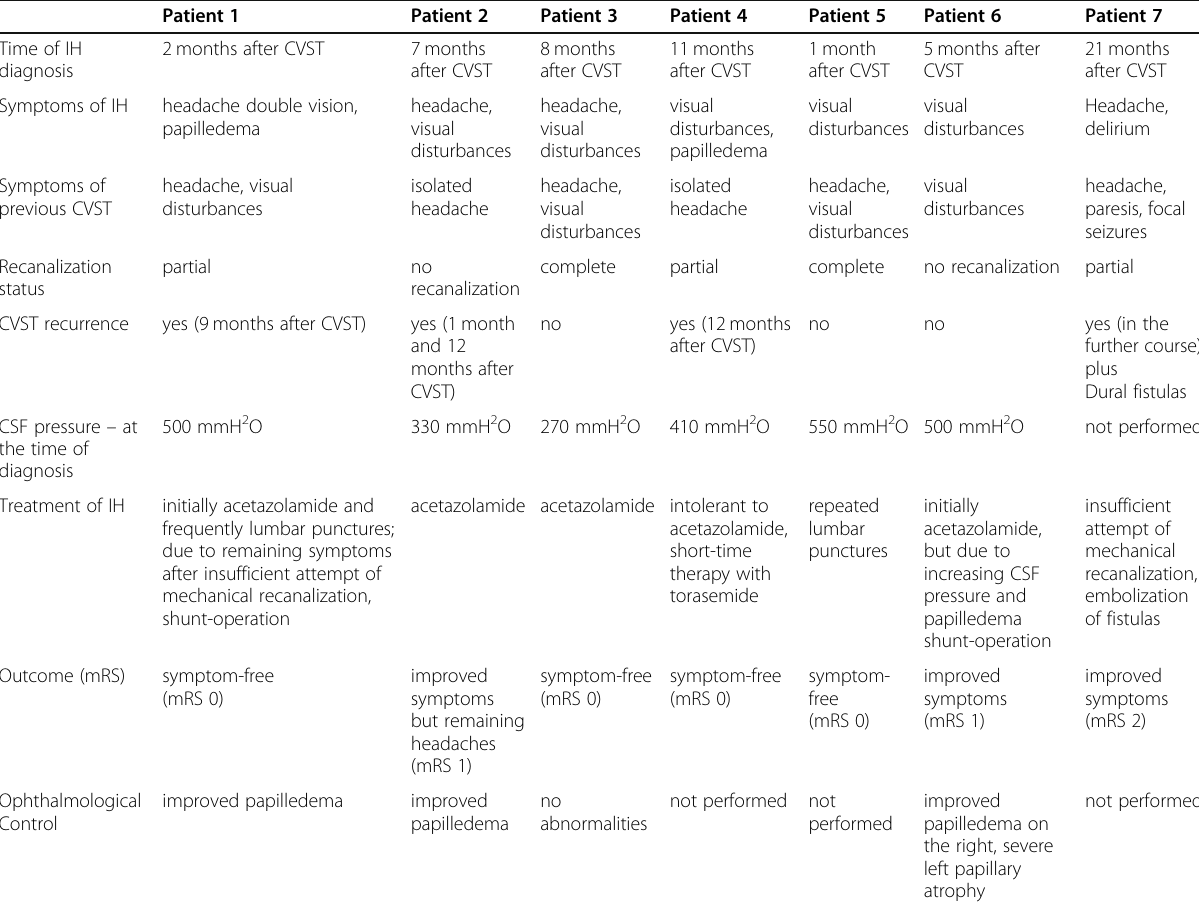
Table 3 Characteristics of chronic IH for each